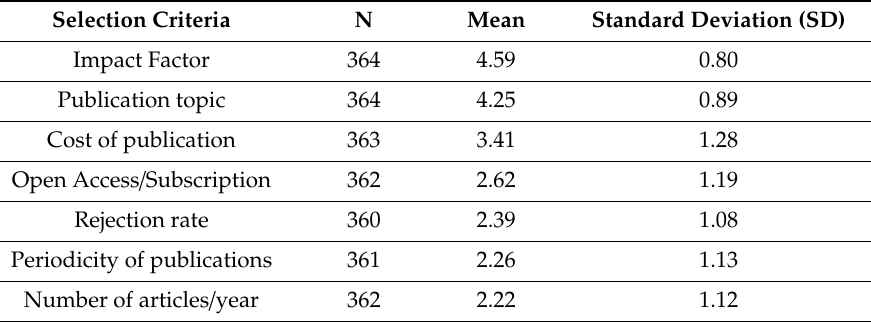
Table 1. Assessment of the selection criteria of a scientific medical